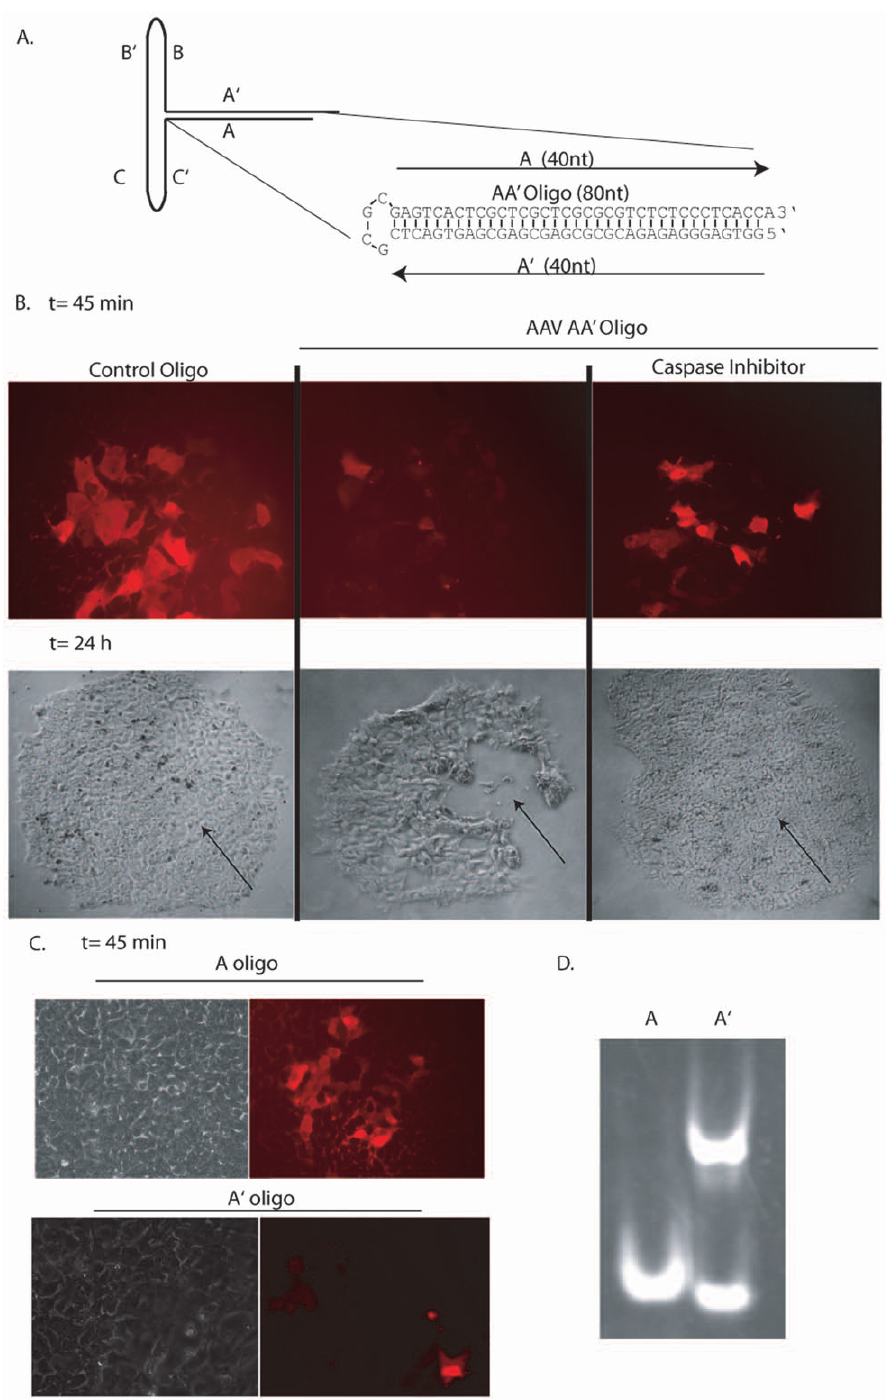
Figure 8. AAV Inverted Terminal Repeats Induce Apoptosis in hESCs. A) Cartoon depiction of the AAV inverted terminal repeat. The experimental oligonucleotides are also depicted as AA’ (80-mer), A (39-mer) and A’ (39-mer). B) hESCs were injected with AA’ or a control oligonucleotide with no AAV sequence under the indicated conditions. The DNA solution contained rhodamine allowing visualization of injected cells (red). Microscopy was performed at the indicated time points. C) DNA microinjections of the A or A’ oligonucleotides as described above. D) Native gel analysis of the A and A’ oligonucleotides as described in the text. doi:10.1371/journal.pone.0027520.g008 transcript upon AAV transduction did not allow detectable p21 micro RNAs, specifically expressed in pluripotent cells, target the protein. Consistently, work has demonstrated the post-transcrip- 3 9 -UTR of the p21 message to down-regulate translation [4]. tional regulation of p21 protein abundance and that multiple Another notable attribute of p53 in hESCs is the ability to induce